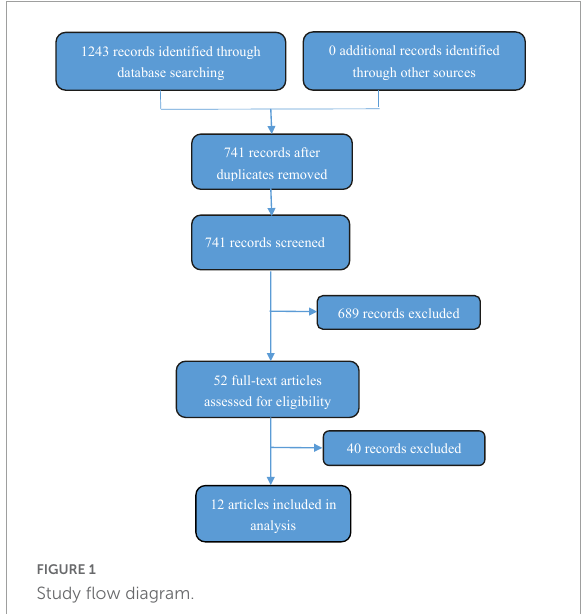
FIGURE1 Study flow